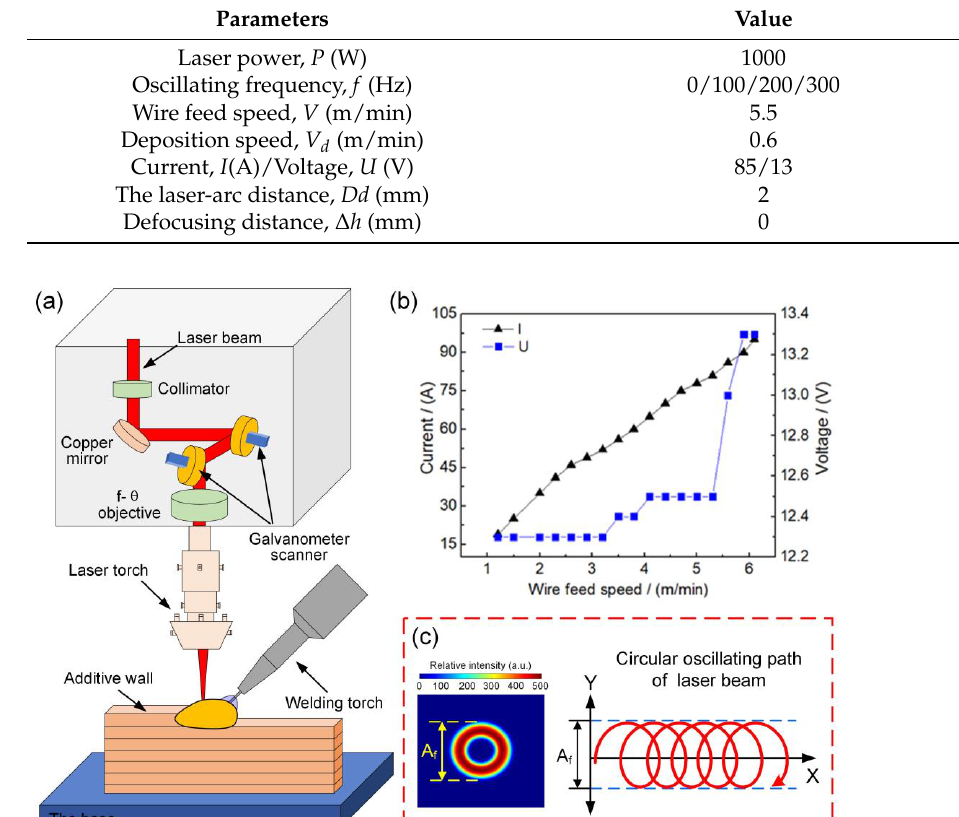
Figure 1. ( a ) The schematic diagram of the oscillating laser-arc hybrid additive manufacturing system; ( b ) the one-dimensional control curve of CMT arc parameters; ( c ) the circular oscillating path of the laser beam.